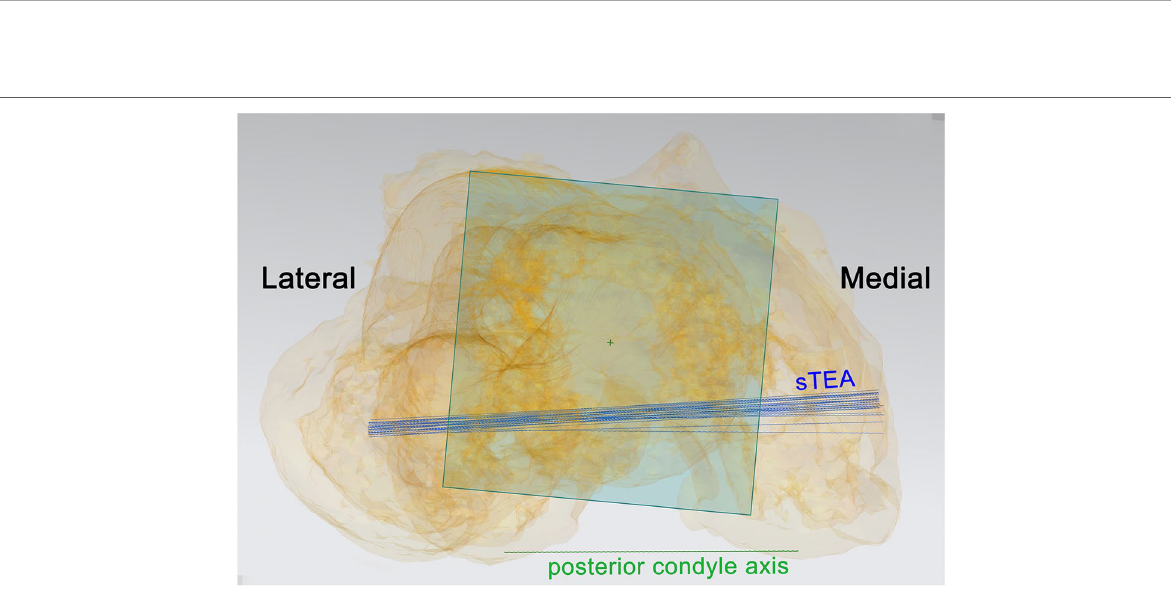
(IQR). Statistical analyses were performed by using SPSS 25.0 (SPSS Inc, Chicago, IL).